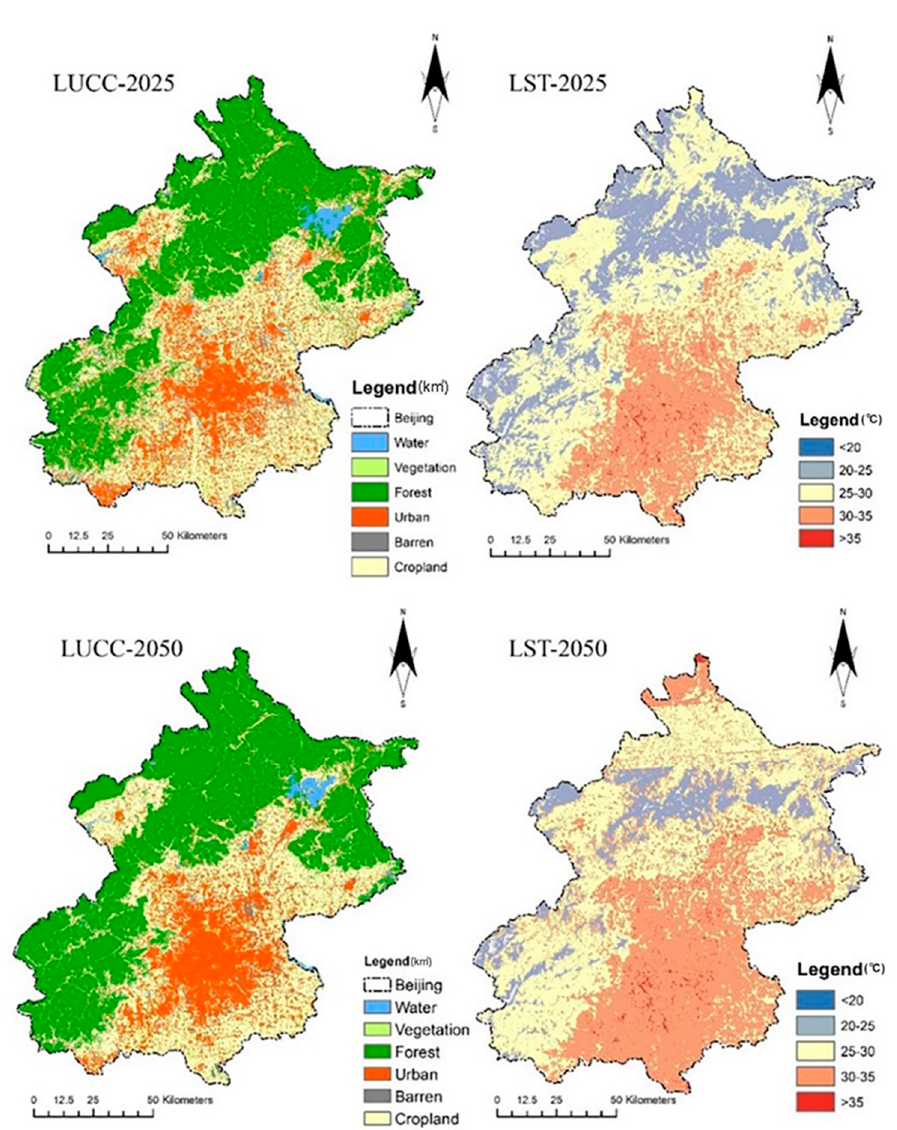
Figure 10. The predicted LULC and LST maps for the years 2025 and 2050.